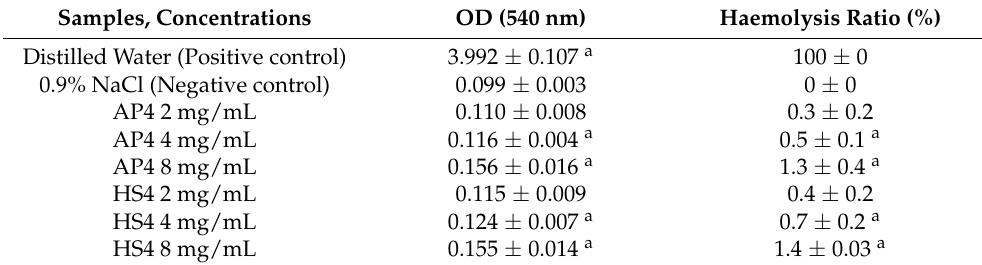
Table 4. Effect of pectin gel beads on haemolysis of whole blood in vitro. Samples,